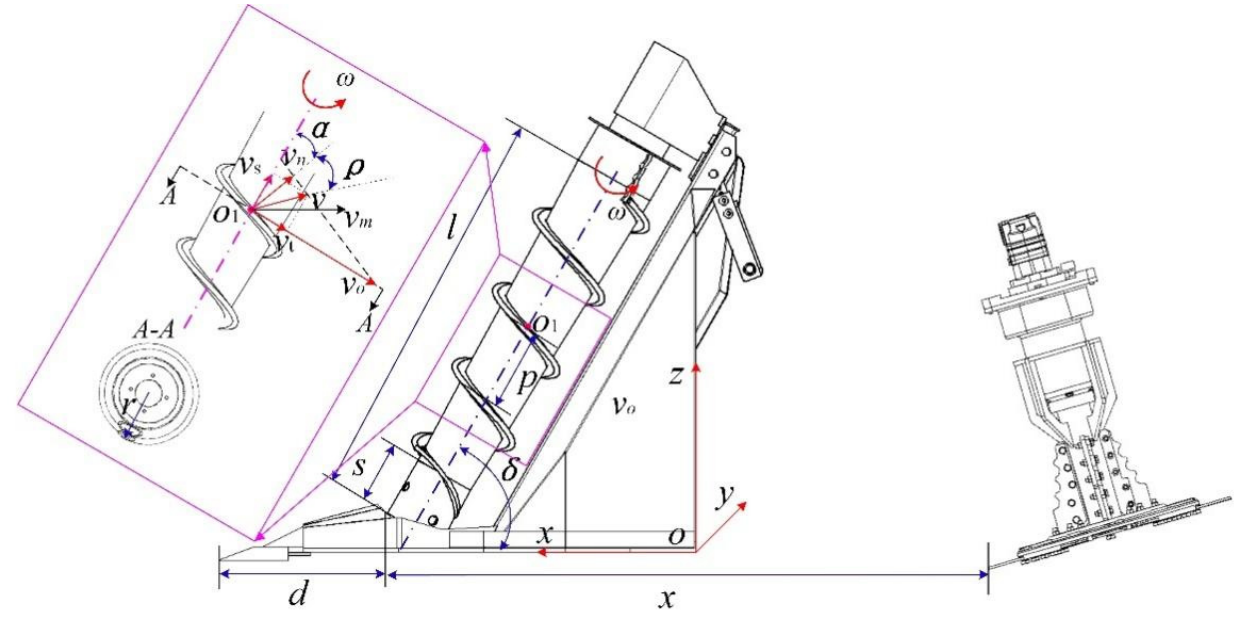
Figure 3. Analysis of the motion parameters of SLS. The sugarcane stalk generates a linear velocity v 0 under the rotation of the lifting drum in the direction tangential to the rotation of the contact point.